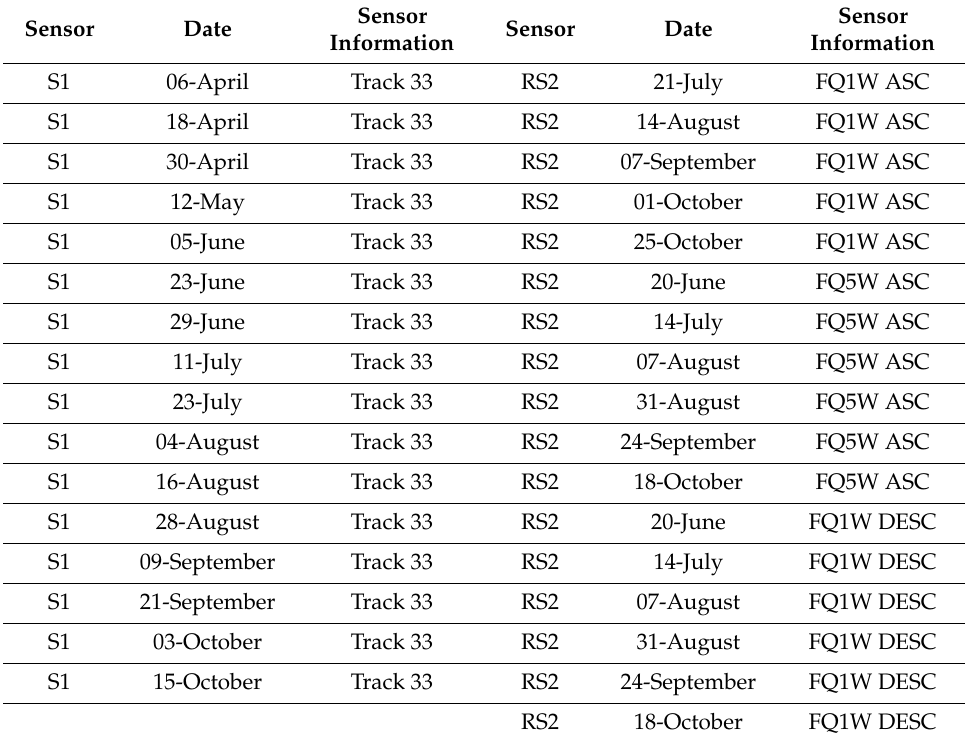
Table1. ListofSentinel-1(S1)andRadarsat-2(RS2)imagesacquiredin2017usedtocreateinterferometric pairs. All RS2 images were acquired 24 days apart. All S1 images were acquired 12 days apart, except for 12 May–5 June, where an image was missing from the archive / was not acquired, and 23 June, where an S1-B image was available enabling 6-day separation of images. ASC = Ascending orbit, DESC = Descending orbit Sensor Sensor Date Information